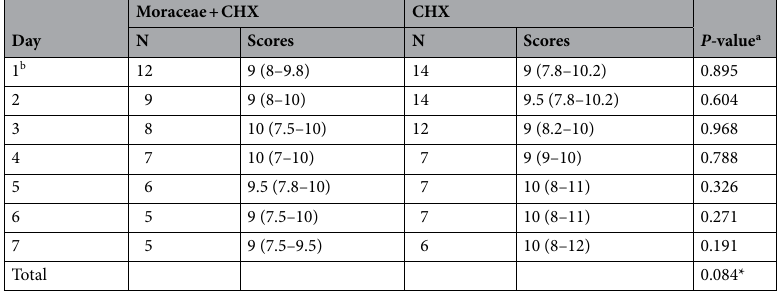
Table 3. Comparison of modified BOAS from days 1–7 between the two groups. Data are presented as the median (interquartile range). BOAS, Beck oral assessment score; CHX, chlorhexidine. a P-value; using generalized estimating equation with the independent correlation matrix. b Missing modified BOAS data on day 1 because of a technical error in data collection.